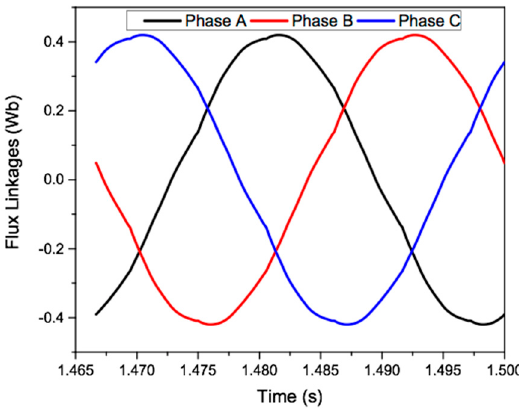
Figure 9. Three-phase flux linkages for the proposed brushless WRSM.